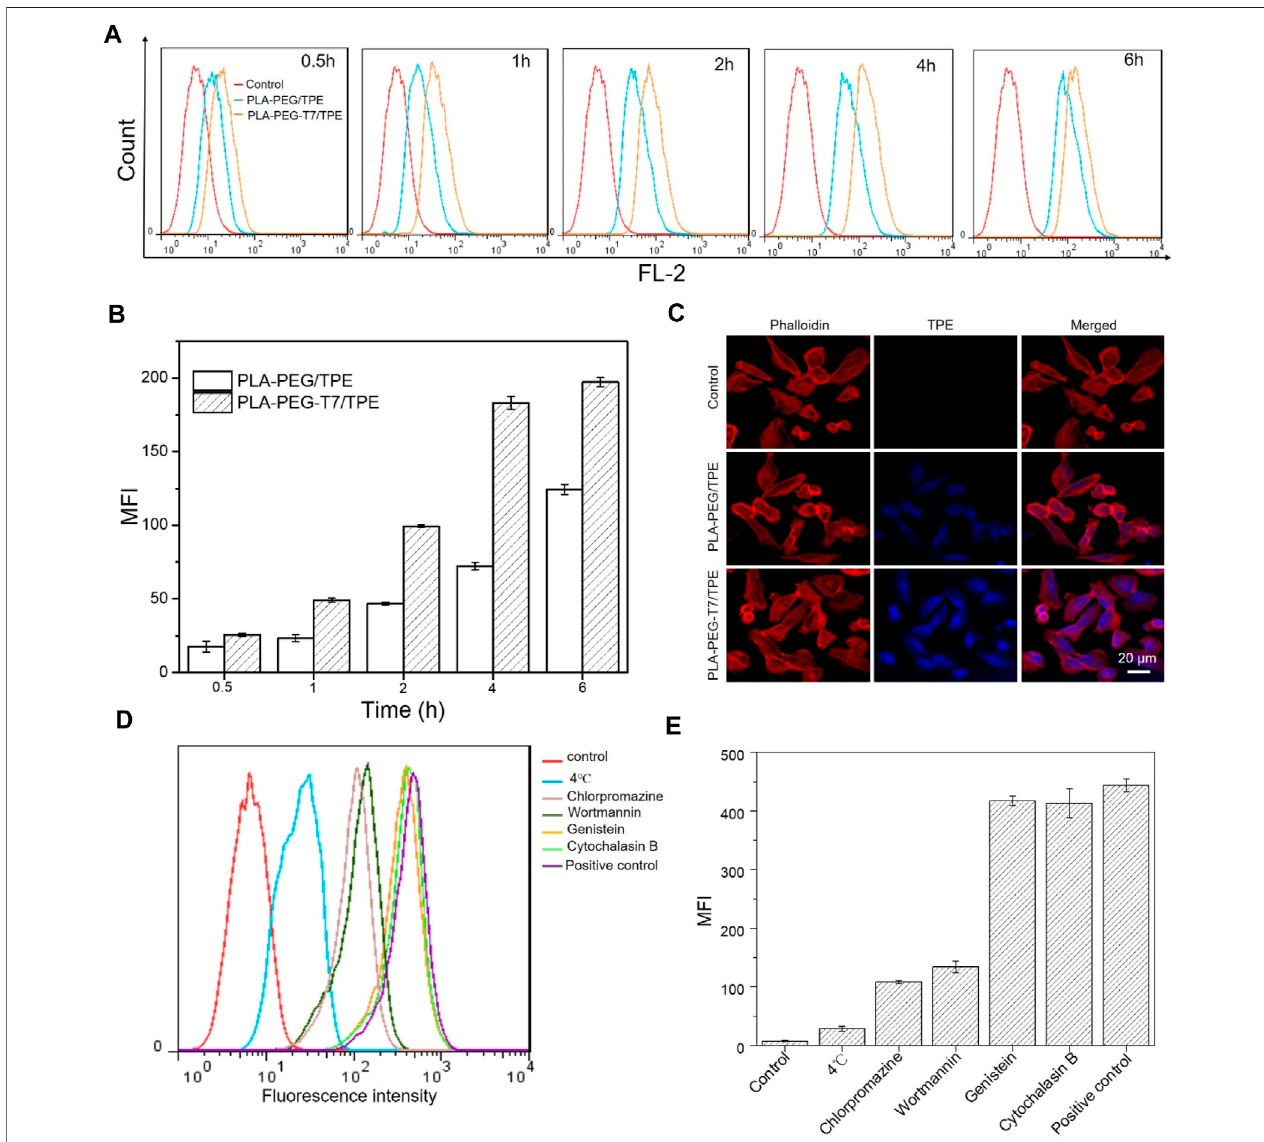
FIGURE2|(A) Flowcytometryanalysisof fl uorescencepeak fi gureinLN229cellsincubatedwithPLA-PEG/TPEandPLA-PEG-T7/TPEfordifferenttime. (B) Mean fl uorescence intensity (MFI) in LN229 cells incubated with PLA-PEG/TPE and PLA-PEG-T7/TPE for different time. (C) Confocal laser scanning microscopy (CLSM) shows the uptake of TPE into LN229 cells between PLA-PEG/TPE and PLA-PEG-T7/TPE a groups in a two-compartment BBB model. (D) Flow cytometry analysis of the effect ofvarious inhibitorson theendocytosis ofPLA-PEG-T7/TPE intoLN229cells. (E) Theeffectofvarious inhibitors onthe endocytosisofPLA-PEG-T7/TPE in LN229